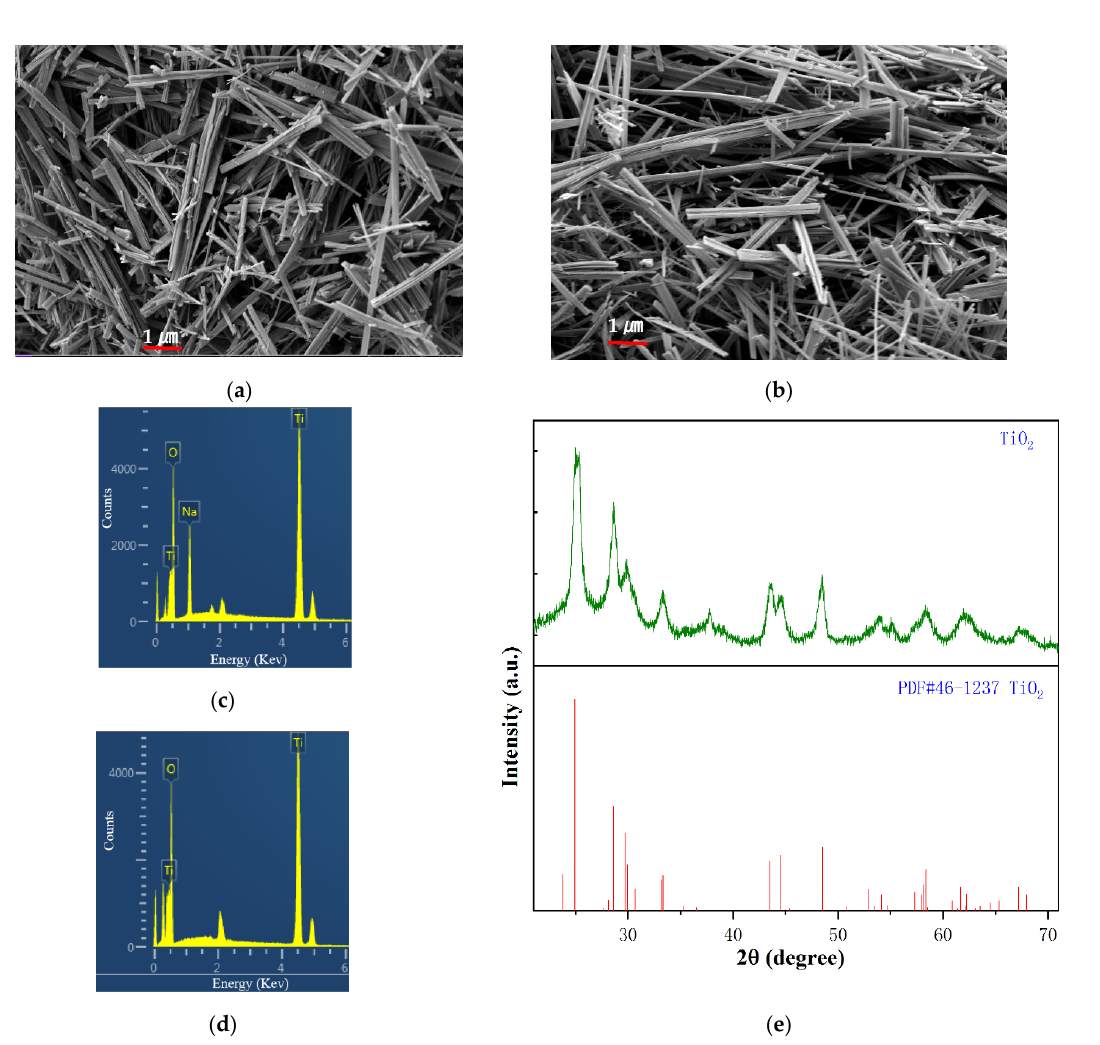
Figure 1. ( a ) SEM image of Na 2 TiO 7 nanobelt; ( b ) SEM image of TiO 2 nanobelt; ( c , d ) EDS spectra of TiO 2 and Na 2 Ti 3 O 7 nanobelt; ( e ) XRD patterns of TiO 2 . EDS, energy-dispersive X-ray spectroscopy.